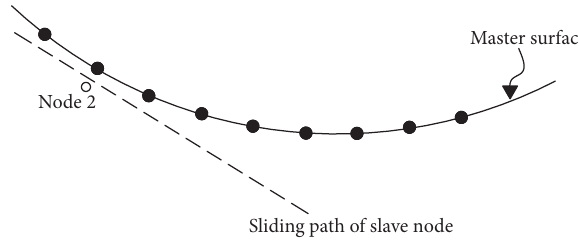
Figure 17: Path of small